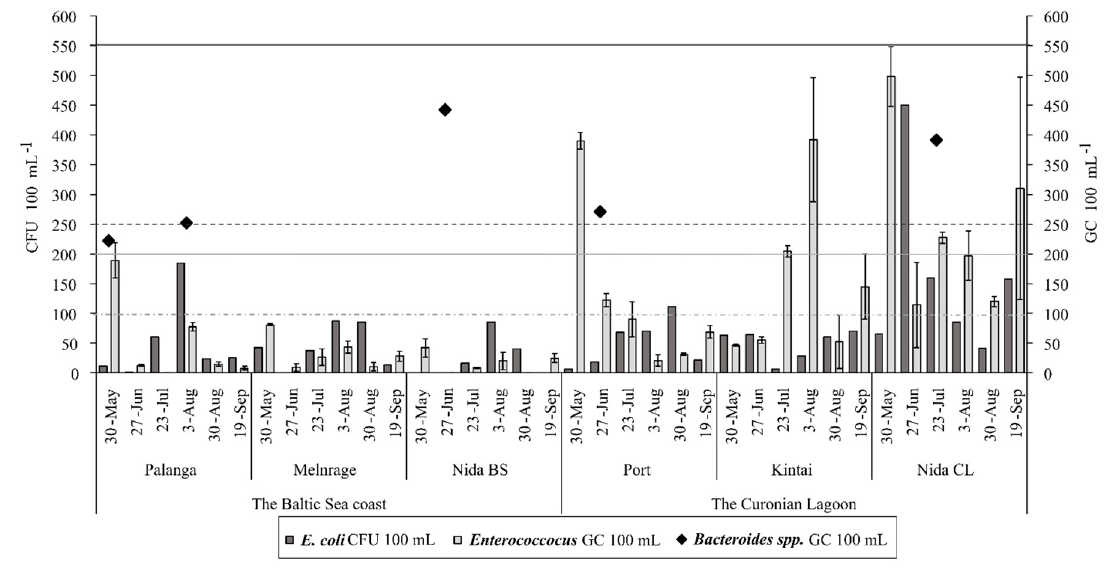
Figure 2. FIB concentration obtained in May–September 2018 along the coast of Lithuania and the Curonian Lagoon. Black horizontal lines represent lower (250 colony-forming units (CFU) 100mL − 1 ) and upper (500 CFU 100 mL − 1 ) thresholds of E. coli ; grey lines represent Enterococcus lower (100 GC 100 mL − 1 ) and upper (200 GC 100 mL − 1 ) thresholds. For Bacteroides sp. ( ♦ ), 860 GC 100 mL − 1 was applied as a threshold level. Error bars represent the SD (N = 3).